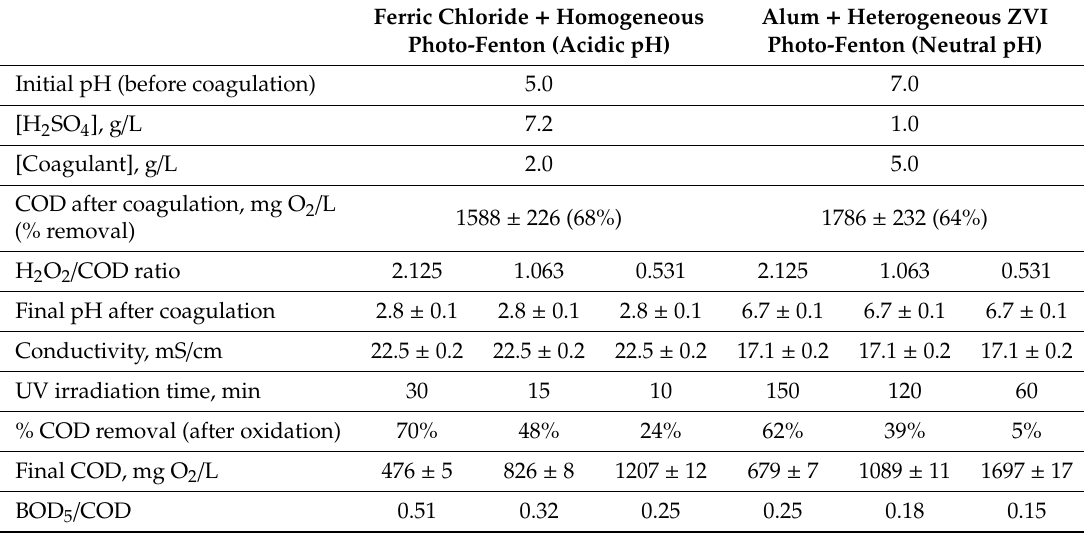
Table 4. Main characteristics of the